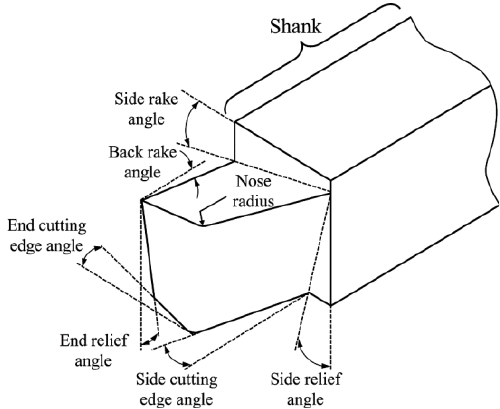
Figure 10. Tool geometry and angles- “reprinted with permission from [1], Copyright @ 2020, John Wiley & Sons, Inc.